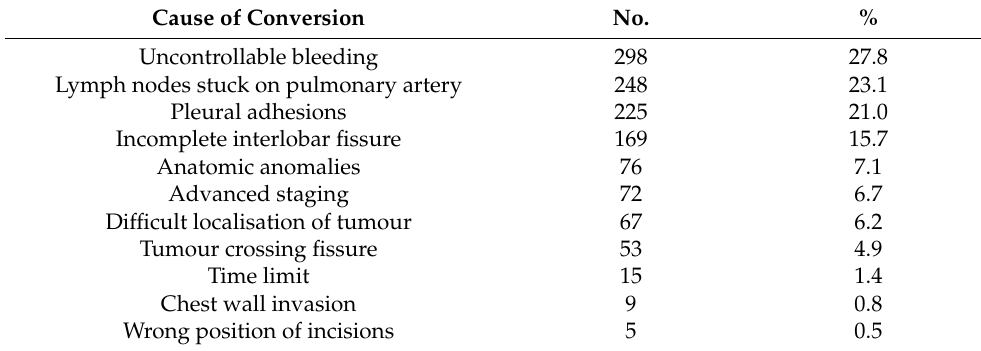
Table 1. Causes of conversion to thoracotomy. The total number of conversions is higher than the total number of cases that required conversion because, in some patients, more than one cause determined the conversion (e.g., severely calcified lymph node on pulmonary artery and uncontrollable bleeding). Cause of